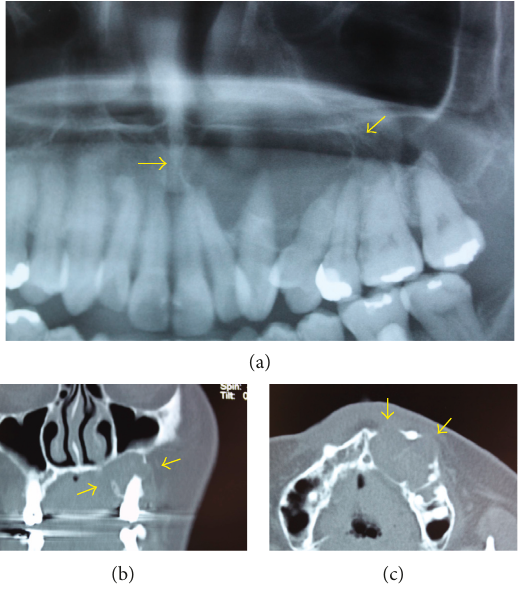
Figure 2: Radiologic and computed tomography (CT) findings. (a) Panoramic radiograph showing a well-delineated radiolucent lesion (yellow arrows). (b, c) CT showing expansion and cortical bone osteolysis (yellow